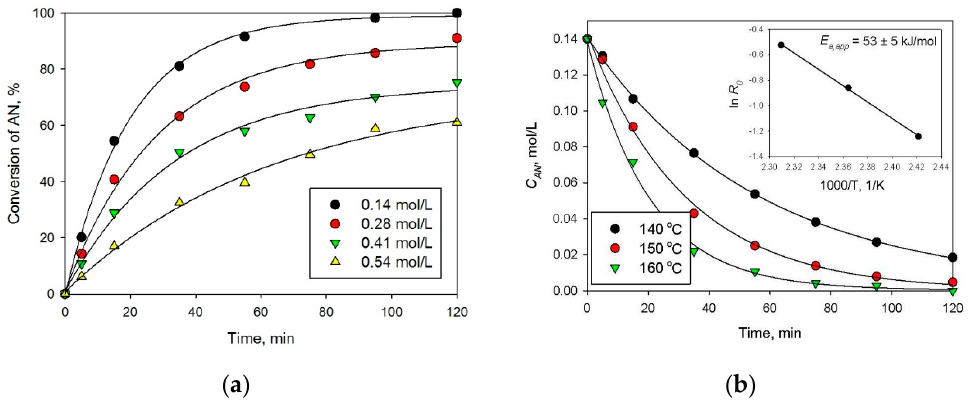
Figure 8. Effect of AN initial concentration ( a ) and temperature ( b ) on selective hydrogenation of AN to CHA using 1 wt.% Pt/HPS (2 MPa, catalyst loading 100 mg).